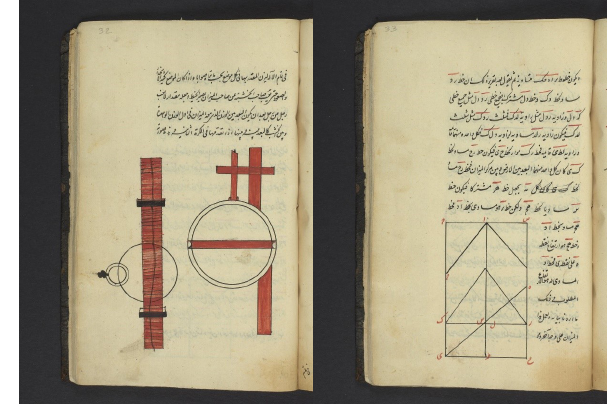
Figure 3. Illustrations of surveyor’s leveling apparatus. Dia- grams f23v and f24r from Karaji (1675). Permanent link: http://hdl. library.upenn.edu/1017/d/medren/9948256513503681 (last access: 29 July 2019).